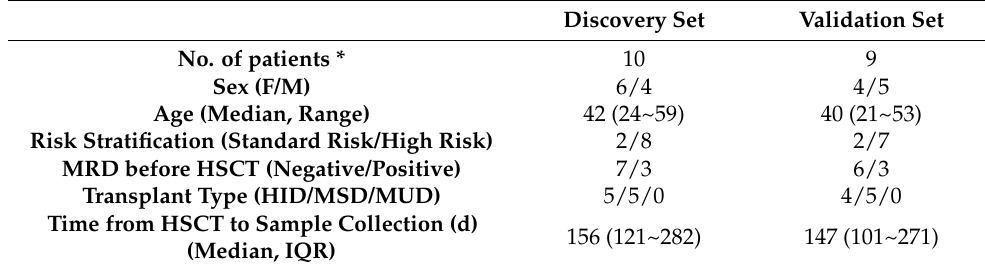
Table 1. Clinical Characteristics of the Individuals Enrolled in the